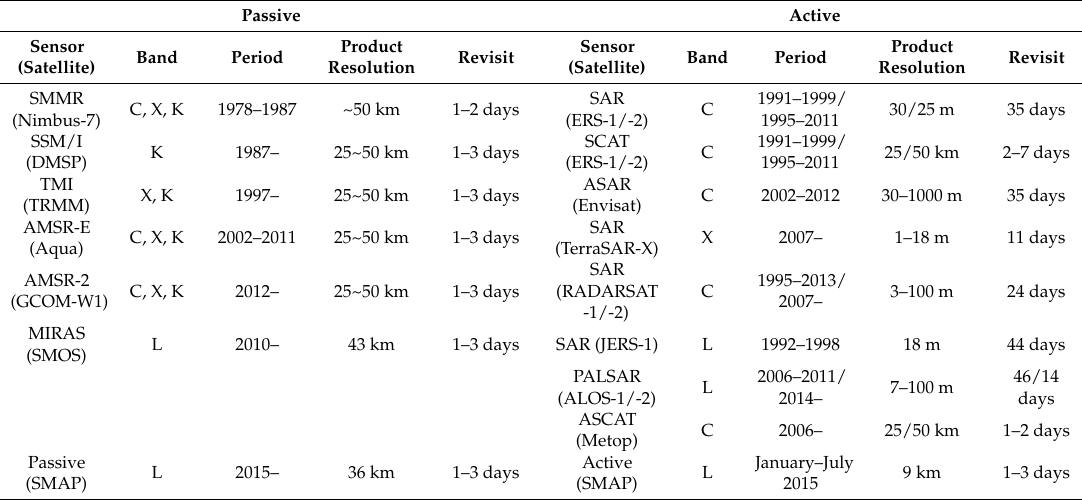
Table 2. Satellite-based microwave remote sensing for soil moisture